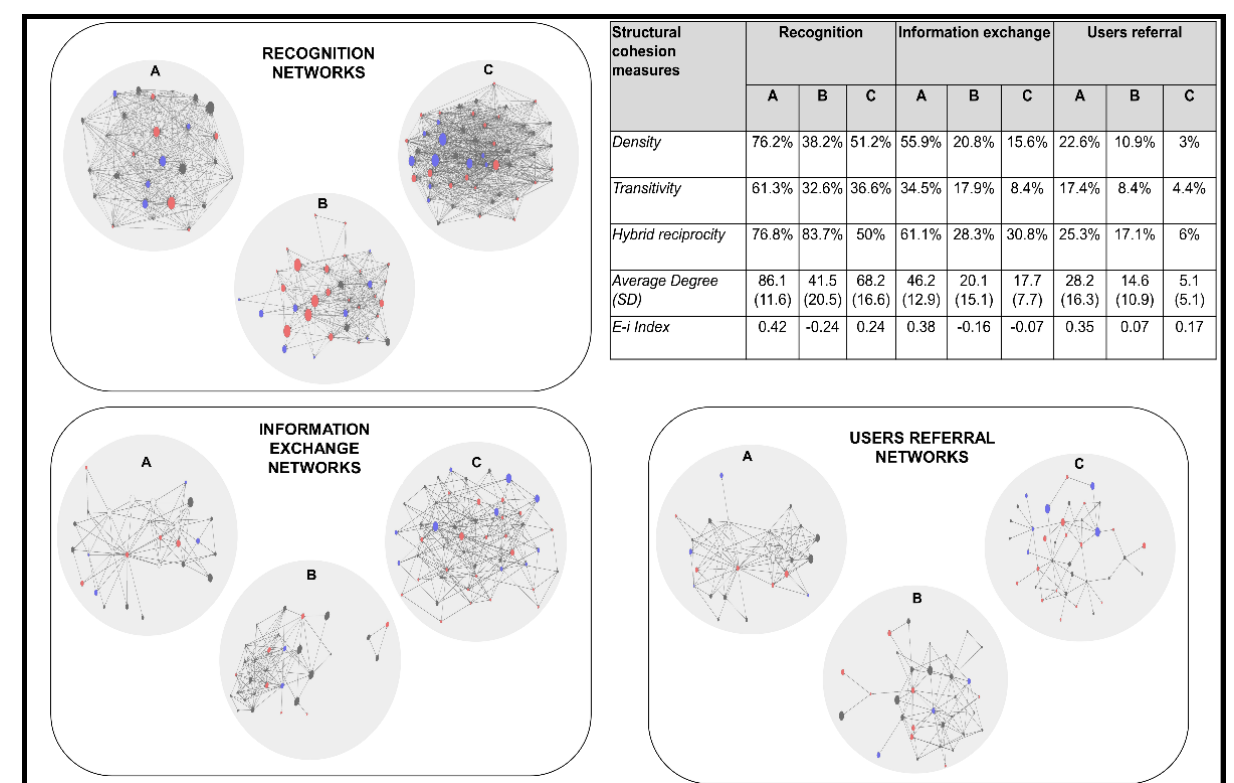
Figure 4. Recognition, information exchange and user referral networks among program imple- menters in the region of Atlántico, Bolívar, and Córdoba and description of the cohesion parameters of each network.